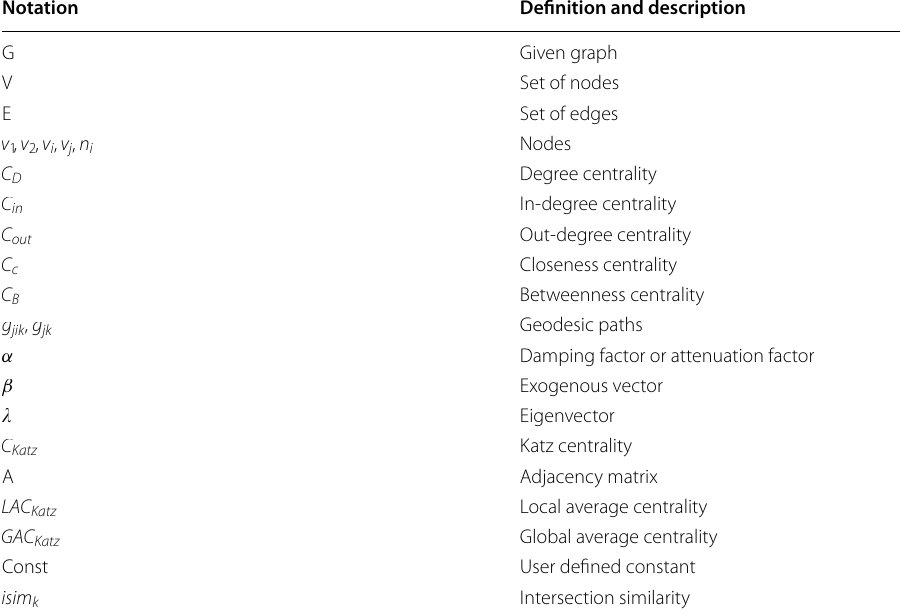
Table 1 Notations and